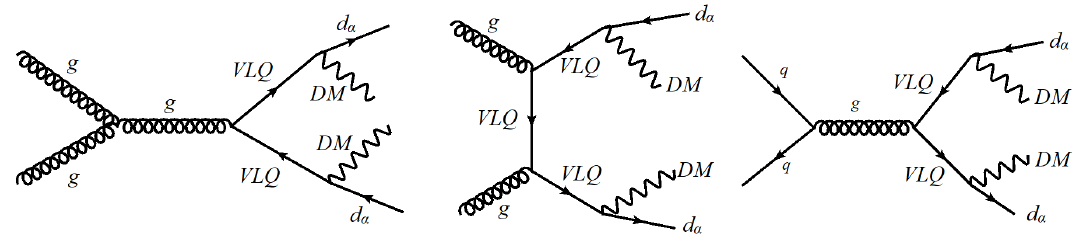
Figure 3 . Leading Feynman diagrams for vector-like quark production and subsequent decays at the